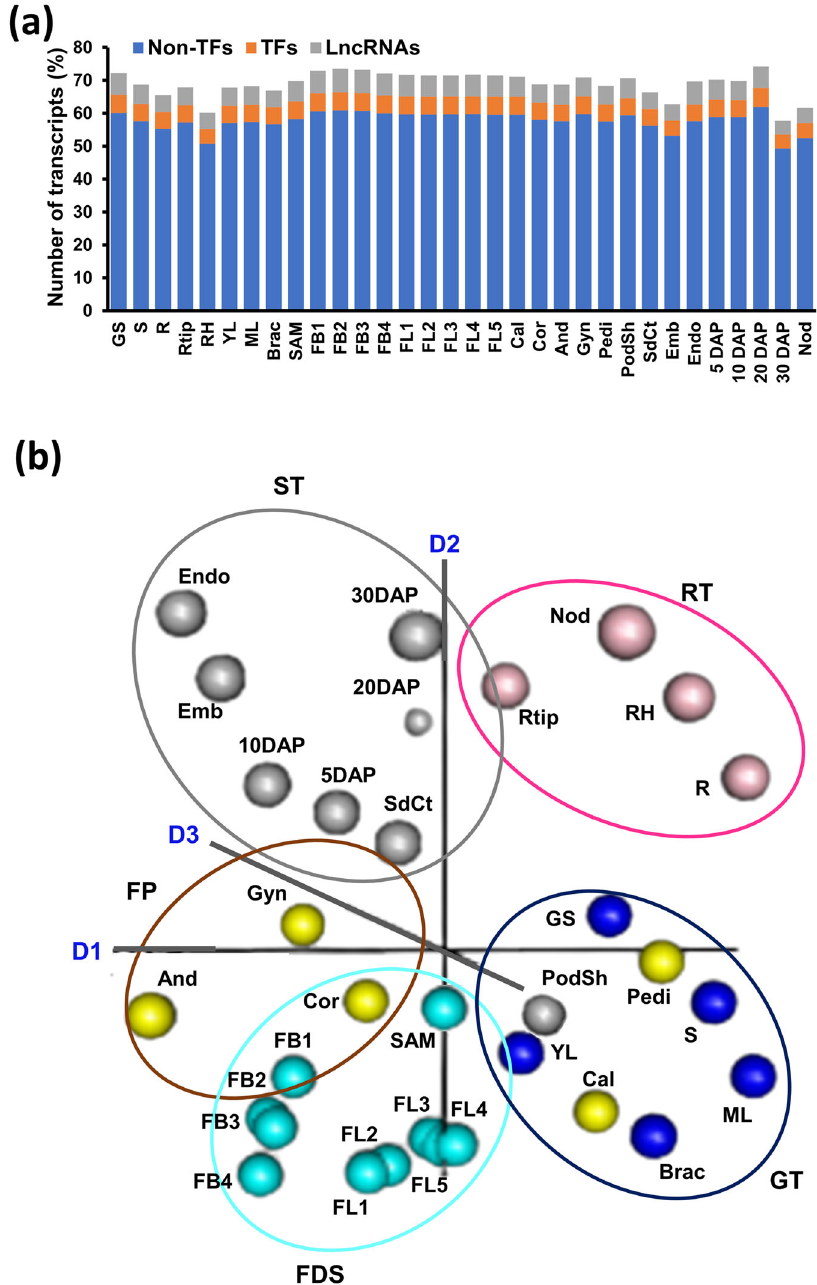
Fig. 2 Expression patterns and correlation of transcriptome in different tissues/organs in chickpea. a Percentage of transcription factor (TF) encoding genes, non-TF protein-coding genes (PCGs) and lncRNAs expressed in the 32 tissues/organs analyzed. b Non-metric multidimensional scaling analysis (NMDS) plot showing correlation among the transcriptomes of 32 tissue/organs samples. The tissues/organs were grouped broadly in fi ve groups; Green tissues (GT, blue), Root tissues (RT, pink), Flower development stages (FDS, cyan), Flower parts (FP, orange), and Seed tissues (ST, gray), indicated in different colors. GS germinating seedling, S shoot, ML mature leaf, YL young leaf, Brac bracteole, R root, Rtip root tip, RH root hair, Nod nodule, SAM shoot apical meristem, FB1 – FB4 stages of fl ower bud development, FL1 – FL5 stage of fl ower development, Cal calyx, Cor corolla, And androecium, Gyn gynoecium, Pedi pedicel, Emb embryo, Endo endosperm, SdCt seed coat, PodSh podshell, 5DAP seed 5 days after pollination, 10DAP seed 10 days after pollination, 20DAP seed 20 days after pollination, 30DAP seed 30 days after pollination. D1, D2, and D3 represent fi rst, second, and third dimension, seed tissues. Among the root tissues, the highest number of TF- encoding genes exhibited tissue-speci fi c expression in root hair (22) and root tip (17), and members of bHLH followed by MYB, AP2-EREBP, and LOB family TFs were found to be most represented. Likewise, AP2-EREBP, C2H2, CCHC, and/or CCAAT TFs displayed tissue-speci fi c gene expression among the green tissues and fl ower parts. LOB and NAC TFs displayed